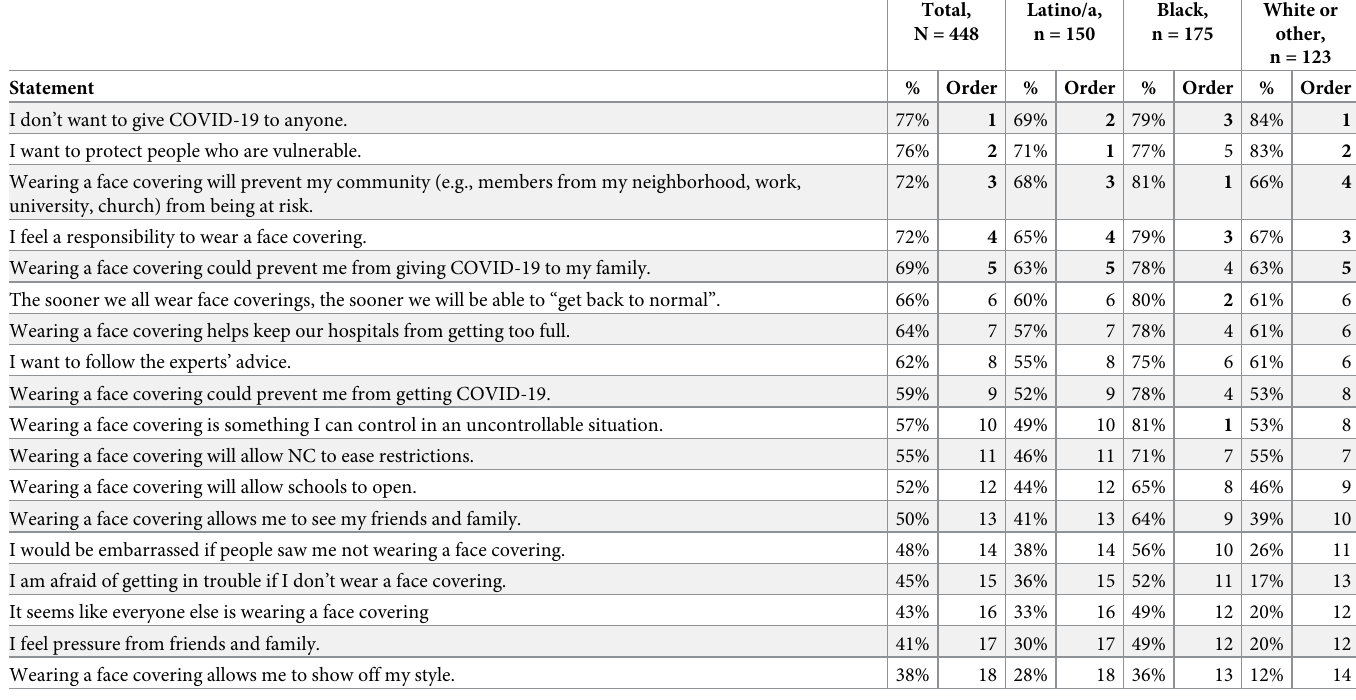
Table 2. Frequency of endorsement of motivations for face covering